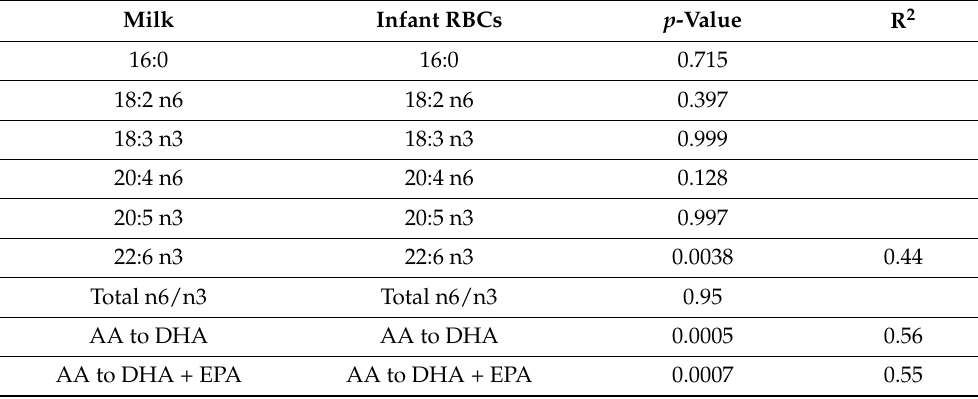
Table 2. Correlation values between milk fatty acid composition and Infant RBC at 4-months postpartum among breastfed infants ( n =